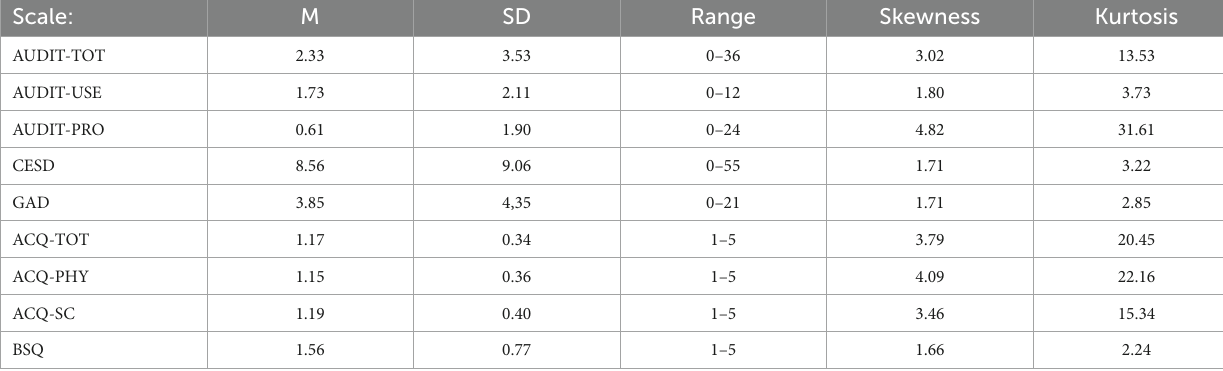
TABLE 4 Means and standard deviations, range, kurtosis, and skewness of scores on the scales of Surinamese respondents. Scale: M SD